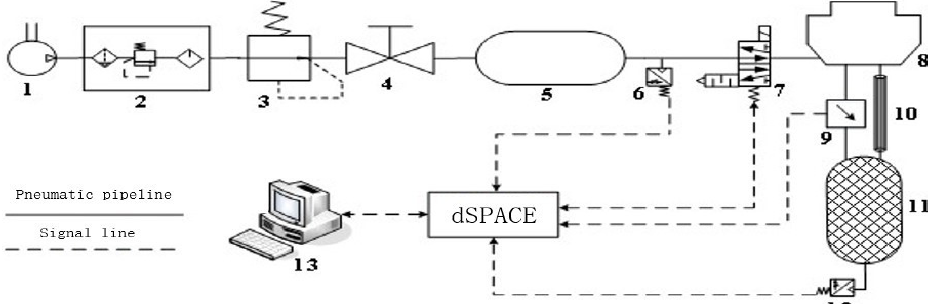
Figure 17. Block diagram of brake pressure change rate measurement. 1-Air source; 2-Pneumatic triplet; 3-Precision pressure reducing valve; 4- switch valve; 5-Air tank; 6,12-Pressure sensor; 7-Tow- position five-way solenoid valve; 8-Brake chamber; 9-Differential pressure sensor; 10-Laminar flow resistance tube; 11-Isothermal container; 13-PC.